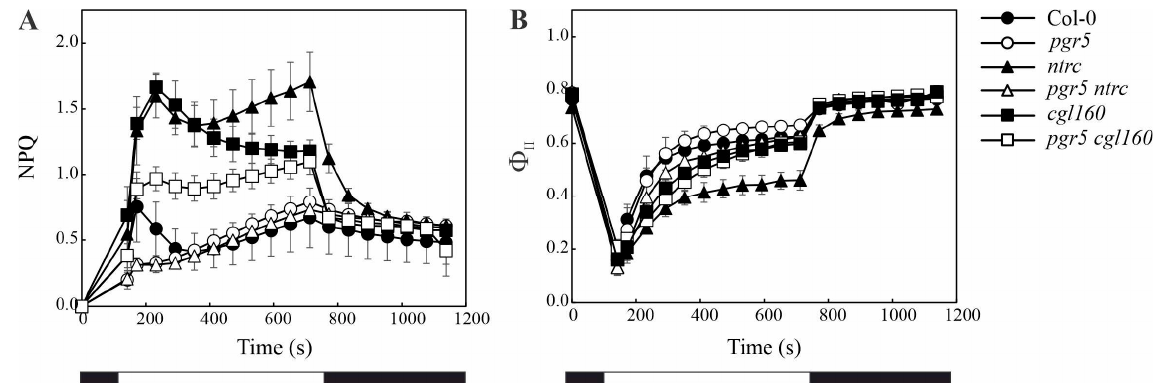
Figure 3. Non-photochemical quenching (NPQ) and photosynthetic performance in ntrc , pgr5 and cgl160 mutants. ( A ) NPQ induction and recovery was monitored in dark-adapted Col-0, pgr5 , ntrc , pgr5 ntrc , cgl160 and pgr5 cgl160 plants grown for 6 weeks under short-day conditions. Plants were illuminated for 10 min with 80 µmol photons m − 2 s − 1 actinic light (white bar), followed by a dark period of 6 min (black bar). ( B ) Photosystem II quantum yield ( Φ II ) corresponding to the measurements shown in ( A ). Averages of at least six replicates are shown. Error bars represent standard deviations. Col-5 (data not shown) behaves like Col-0.